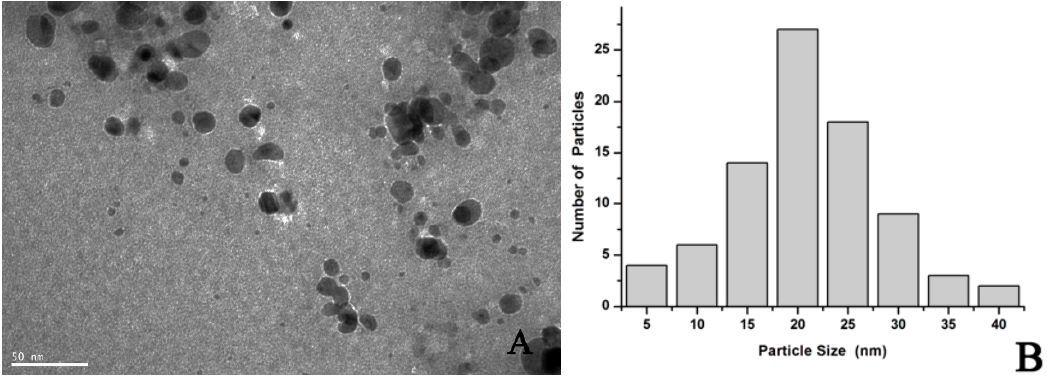
Figure 7. ( A ) Representative images of AgNPs synthesized by the reduction of AgNO solution with the dialyzed cell filtrate and NADH; ( B ) Size distribution of the AgNPs from TEM analysis.